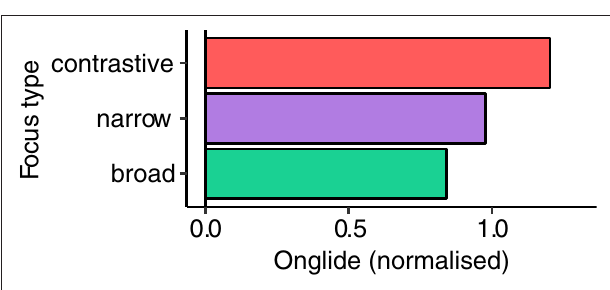
FIGURE 4 | Mean values of rising onglides in broad, narrow, and contrastive focus (group of accented target